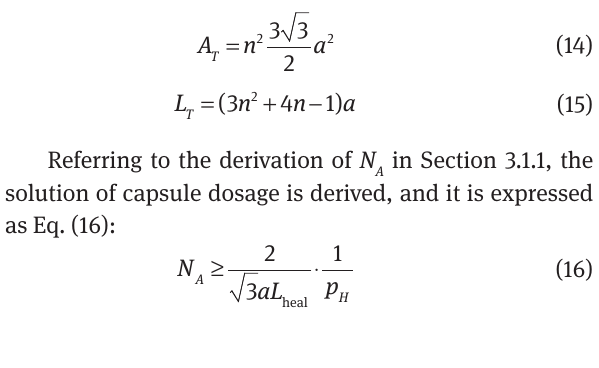
Figure 5, a complex sampling region E 3 is selected, and n 2 regular hexagons exist in the region. The area of region A , and length of cracks L T (14) and (15),